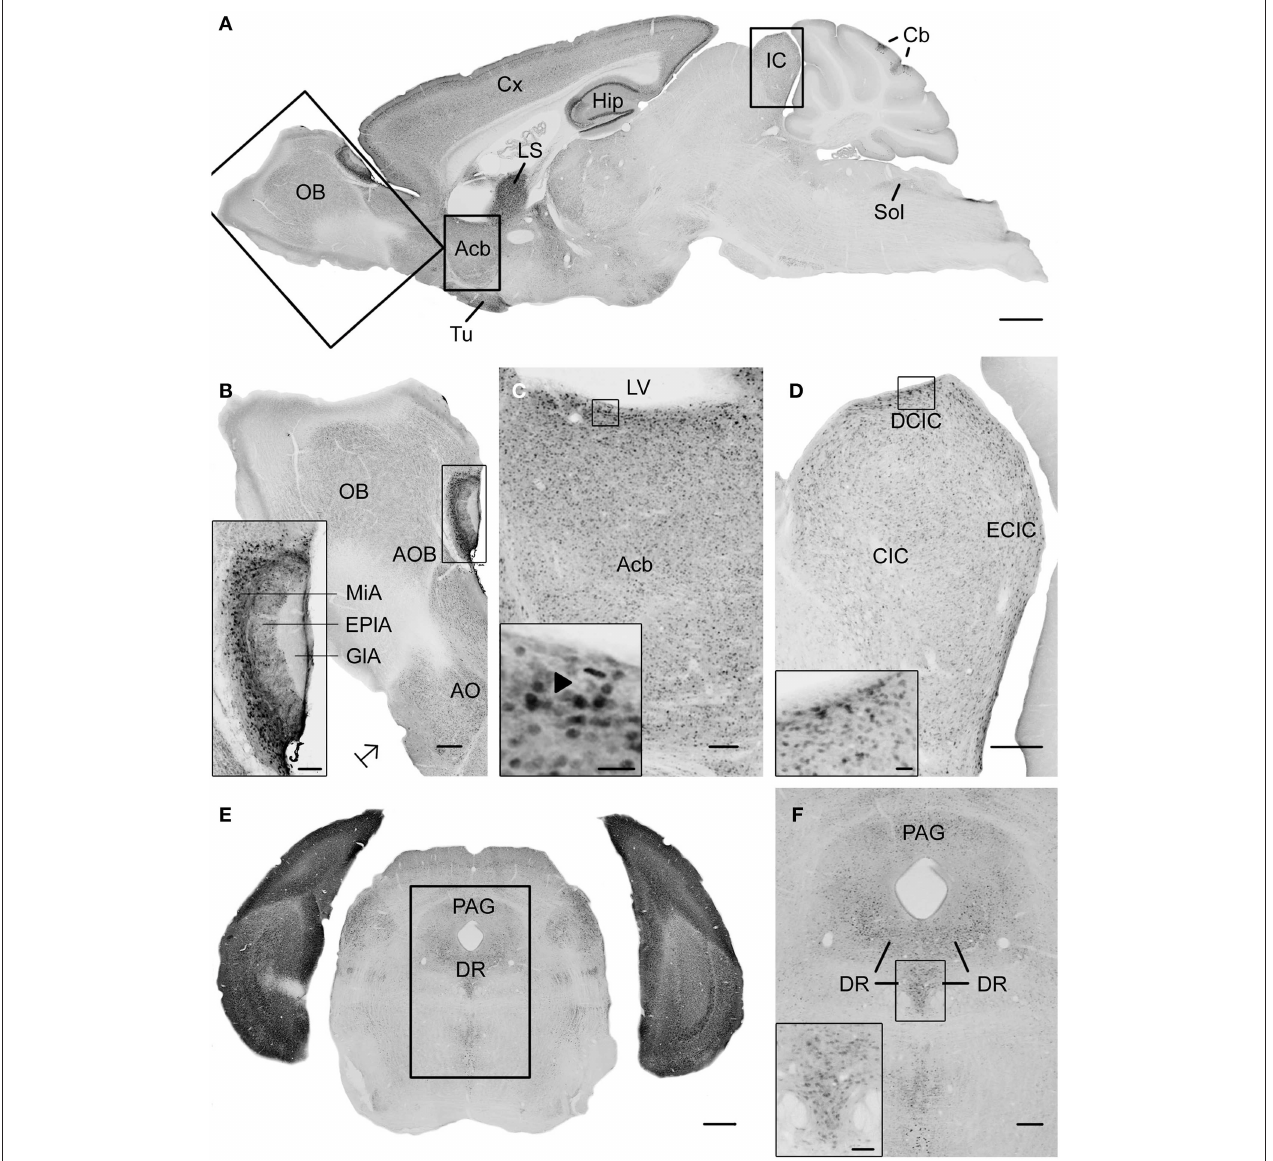
FIGURE 1 | Photomicrographs of UBB + 1 distribution in the brain of UBB + 1 tg mice (line 3413) shown in sagittal and coronal sections. (A) Sagittal overview of UBB + 1 staining in a 7-month-old 3413 tg mouse corresponding to sagittal figure 106 in the mouse brain atlas of Franklin and Paxinos (2007) with rectangles showing the locations of higher magnifications in (B–D) . (B) OB, (C) Acb and (D) IC. (B) Shows the presence of UBB + 1 in neurons of the OB, accessory olfactory bulb (AOB) and the anterior olfactory area (AO) at higher magnification. The insert shows a higher magnification of the AOB. (C) UBB + 1 expression in the Acb. Insert shows higher magnification of UBB + 1 -positive cells. Filled triangle shows a cell in which the UBB + 1 staining is cytoplasmic and the nucleus is negative. (D) UBB + 1 -immunoreactivity in the IC. Insert shows a higher magnification of the immunoreactive cells in the DCIC. (E) Coronal section of a 15-month-old 3413 tg mouse showing the presence